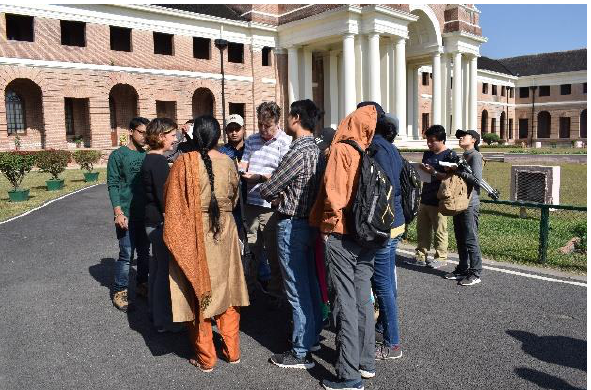
Figure 3. Field work in Progress. Figure 4. Schematic cross section showing the best fitting